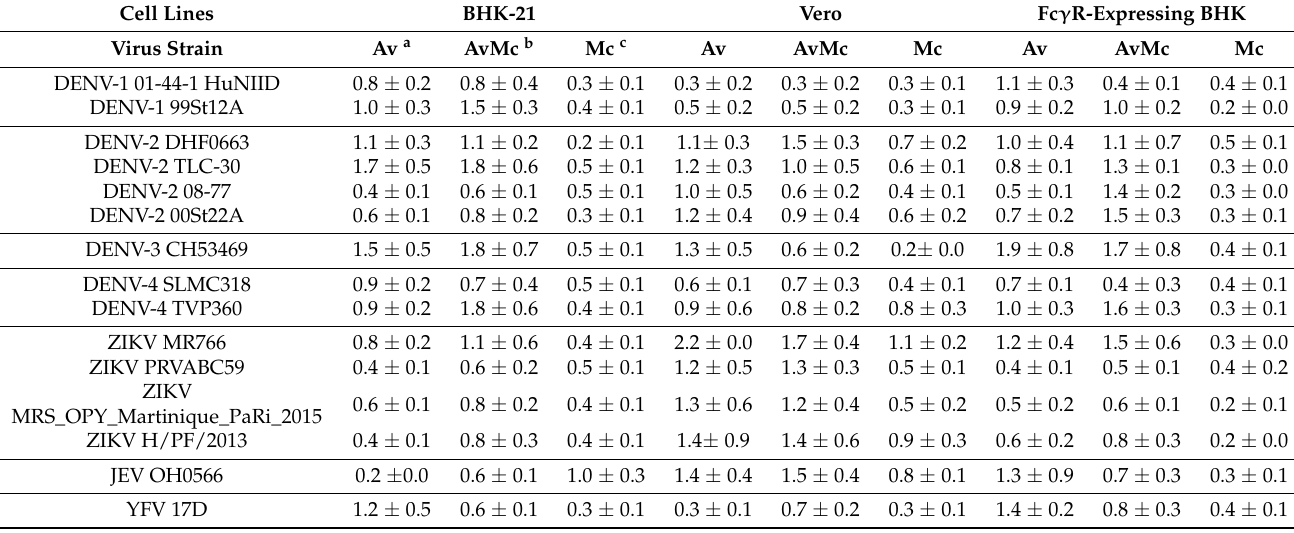
Table 2. Average plaque size (mm) of 15 flavivirus strains using BHK-21, Vero, and Fc γ R-expressing BHK cell lines. Cell Lines